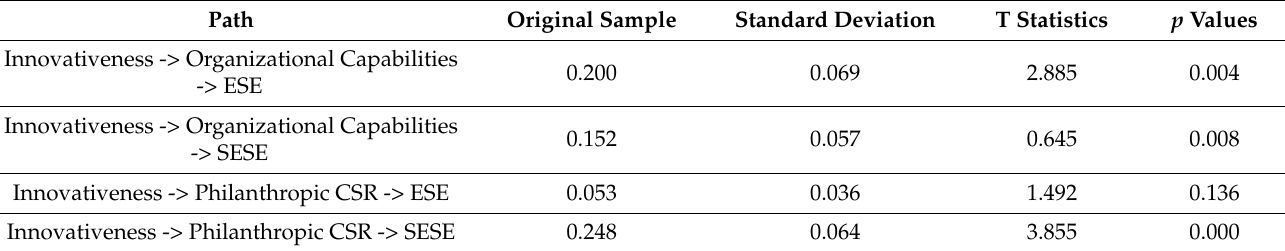
Table 3. Bootstrap results for indirect effects.